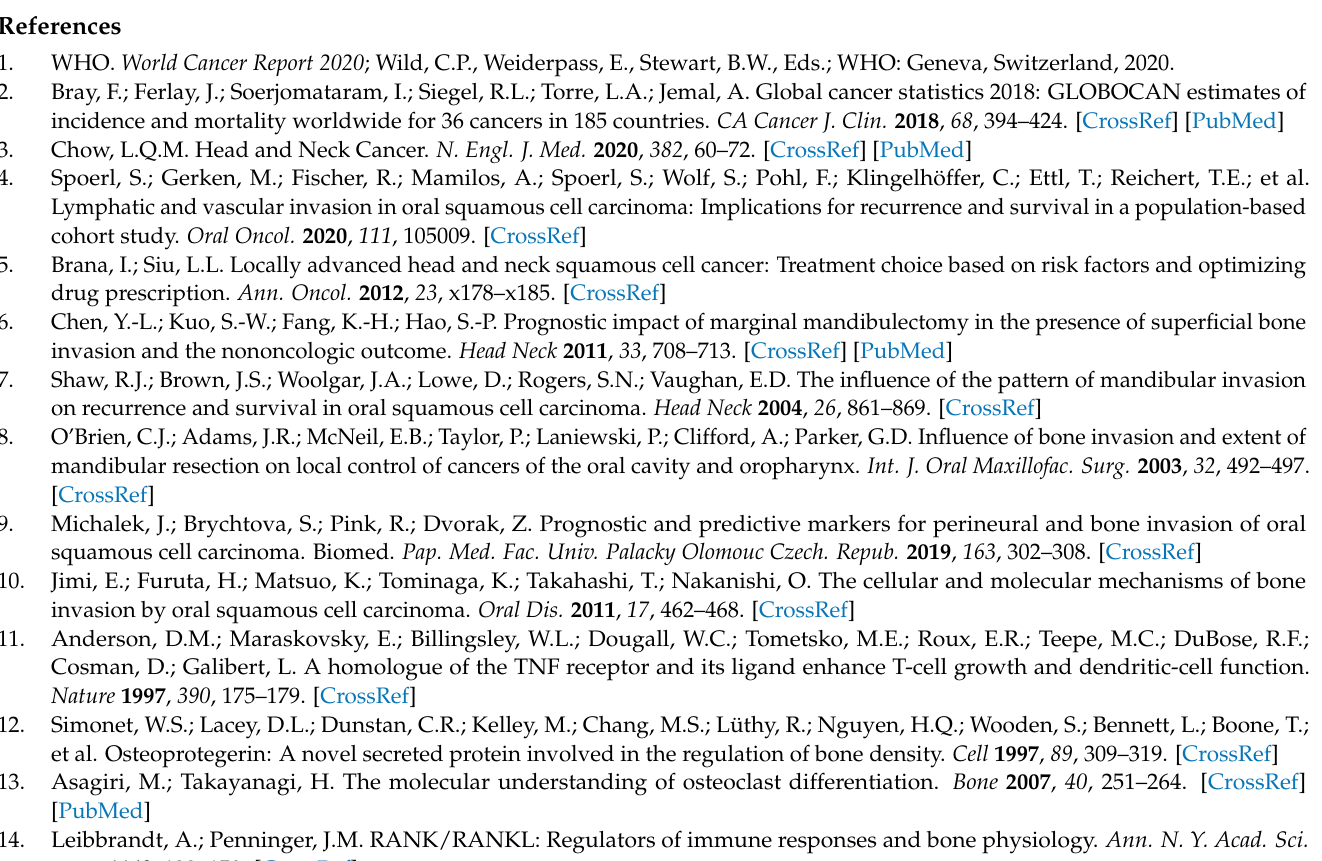
Figure S2: Kaplan–Meier survival analysis of TMA patients; Table S2: Cox regression analysis of overall survival in TMA